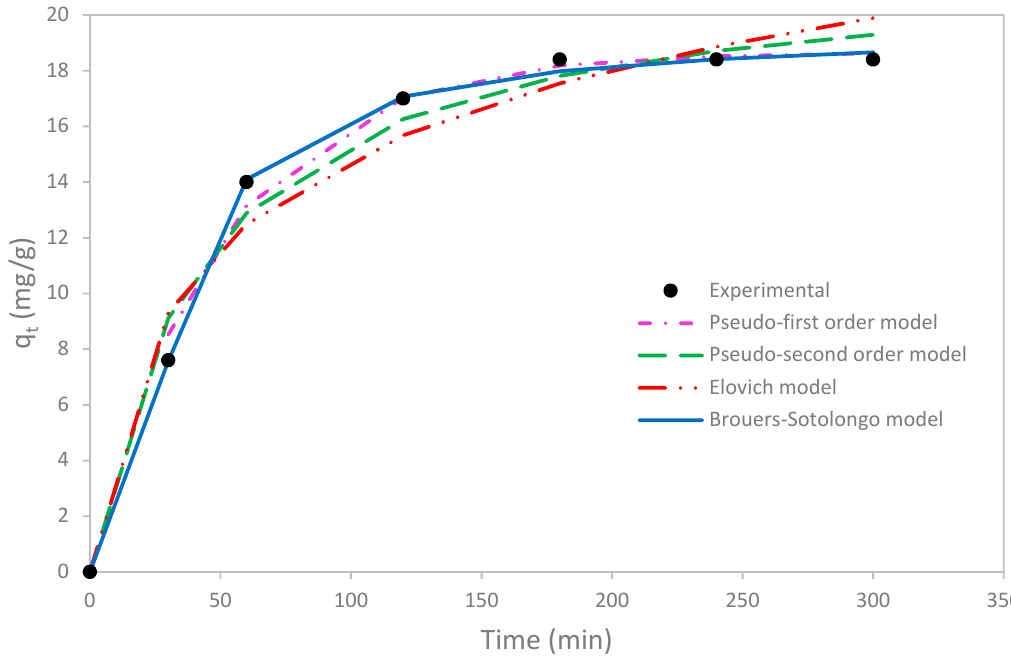
Figure 7. Experimental and theoretical kinetic data of copper adsorption on olive mill solid waste.